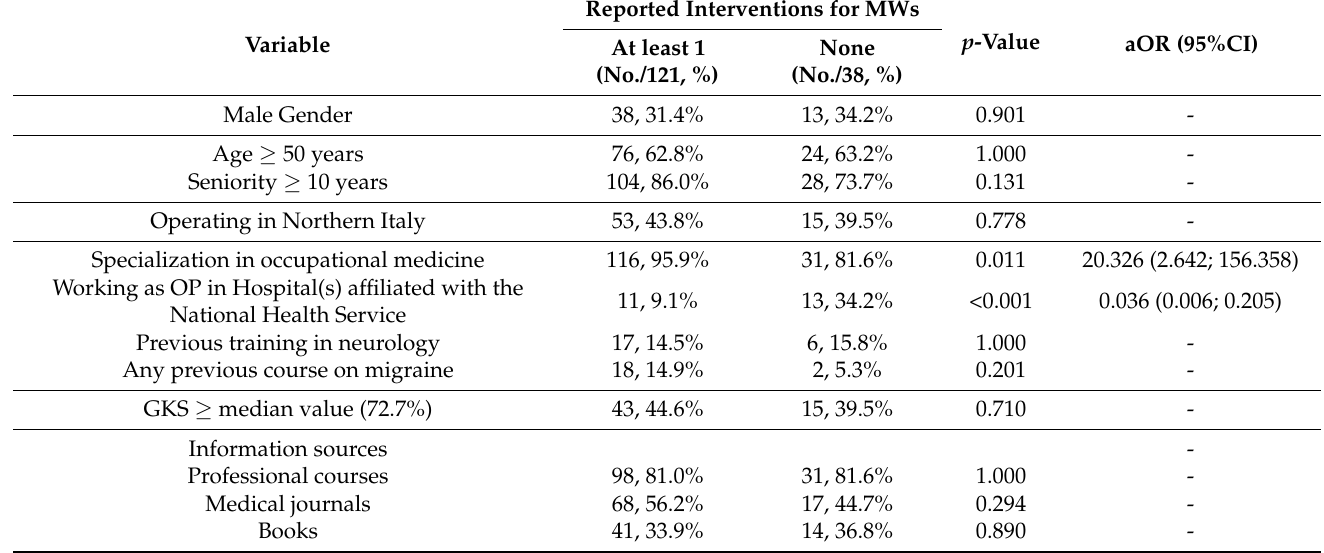
Table 6. Analysis of factors that in participating Italian occupational physicians (OP) having pre- viously managed migraineur workers (MW, No. = 159) were associated with having applied any conditional medical judgment and/or restriction. Comparisons were performed by means of chi squared test. All factors that in univariate analysis were associated with the outcome variable of having reported at least an intervention for MW ( p < 0.050), were included a logistic regression analysis model as explanatory variables, with calculation of corresponding adjusted odds ratios (aOR) and their respective 95% confidence intervals